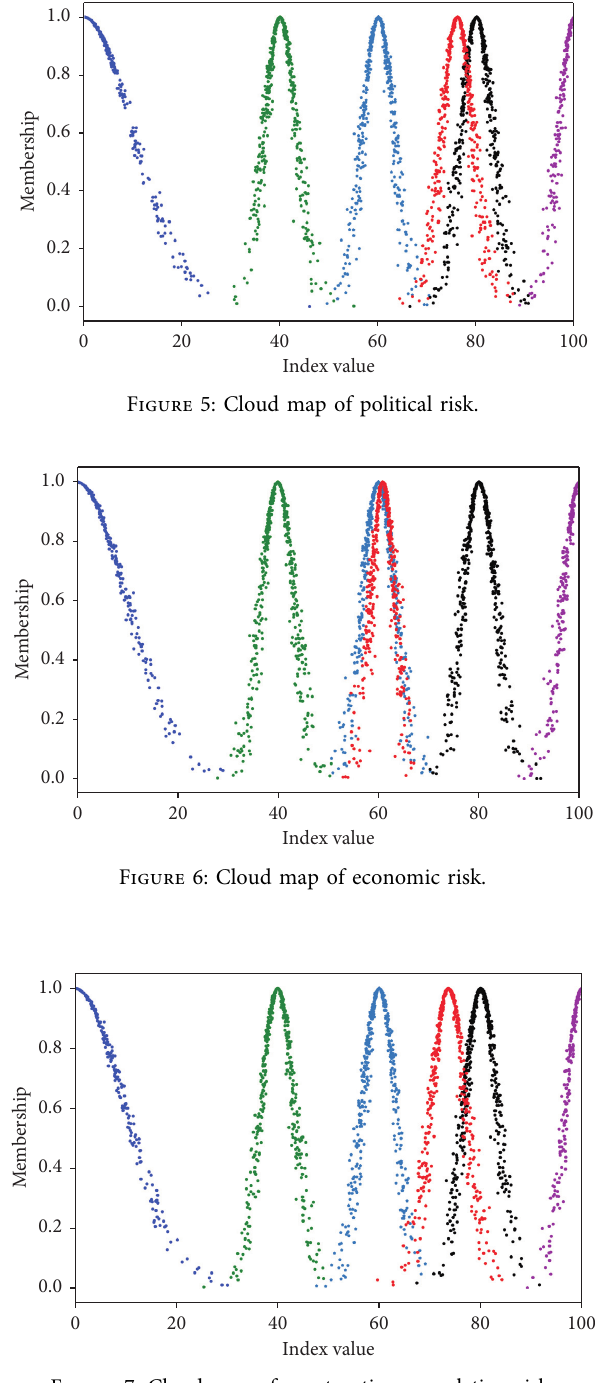
Figure 7: Cloud map of construction completion